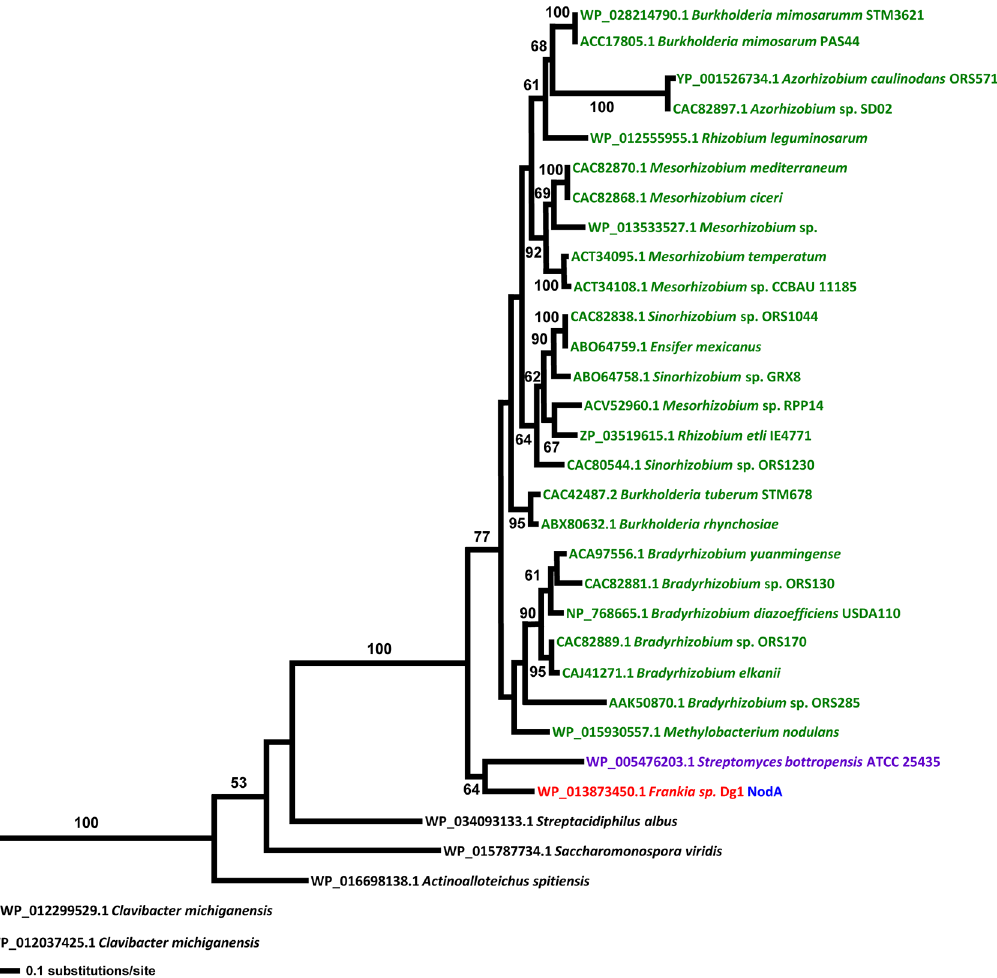
Fig 2. Maximum Likelihood trees of NodA proteins. All rhizobial sequences are given in green, all sequences from Dg1 are given in red, sequences from Streptomyces bottropensis are given in purple. The Dg1 NodA sequence is indicated in blue. All sequences used for the phylogenetic analysis are given in S6